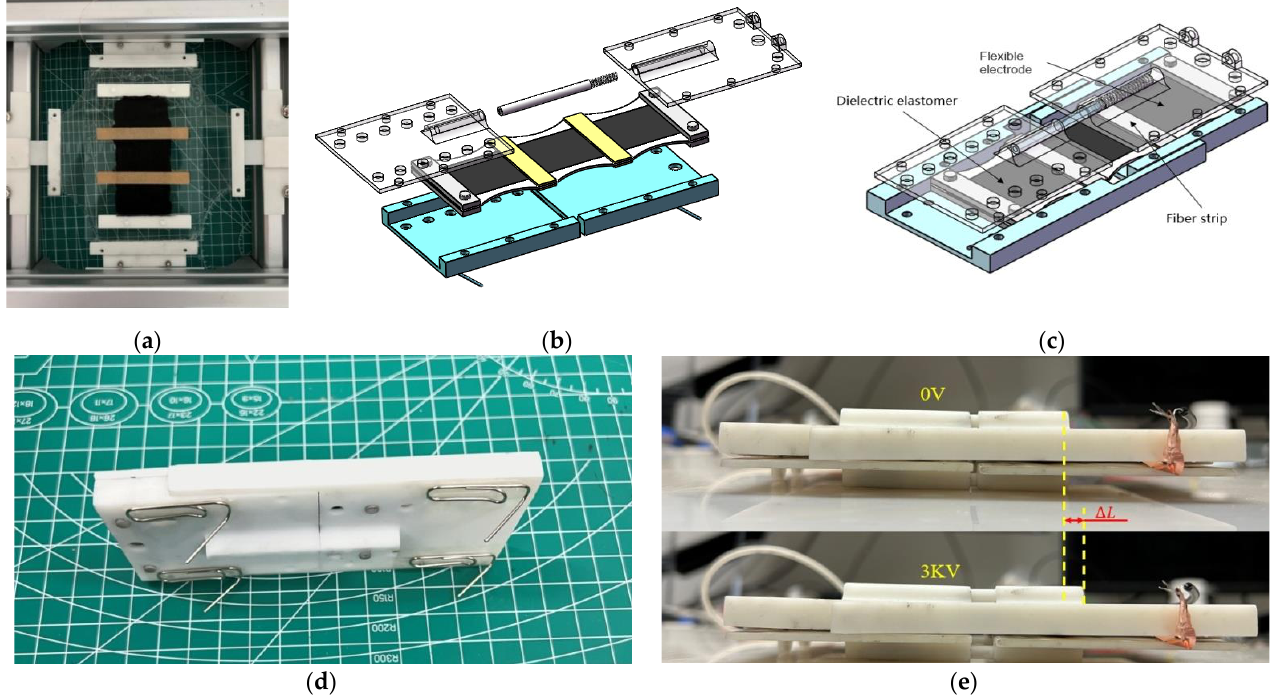
Figure 1. ( a ) The picture shows the pre-stretching device of the DE membrane. The device mainly consists of aluminum alloy and the 3D-printed clamping device, the device can pre-stretch the DE membrane 3 – 6 times. ( b , c ) A sketch of the model of the actuator, consisting mainly of the housing, the spring, the DE membrane, and the support bar. ( d ) A diagram of the friction foot of the actuator, which provides backward friction so that the actuator can move forward. ( e ) The actuator was elongation tested and the elongation of the actuator after power applied was Δx .